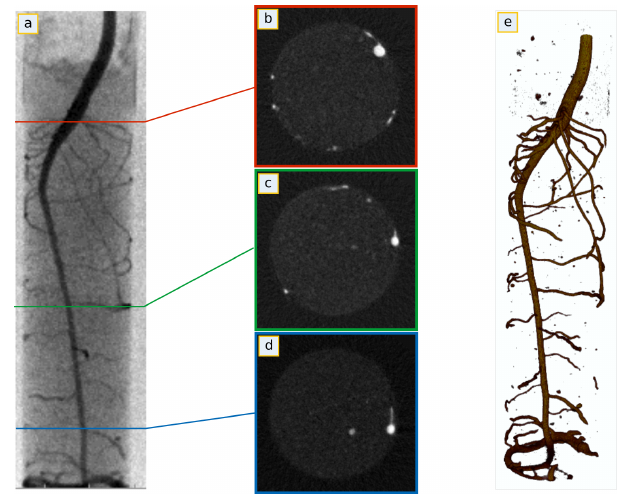
Figure 4. (a) Neutron radiography of a 2-week old lupine in a cylin- drical container of sandy soil, 27mm in diameter. (b, c, d) Horizon- tal slices of the reconstructed data at different depths indicated by the colored lines in the radiography. (e) 3-D rendering of the root system reconstructed using 181